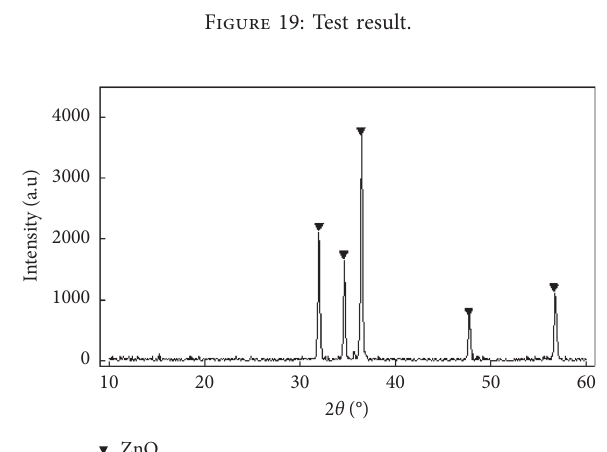
Figure 19: Test result.